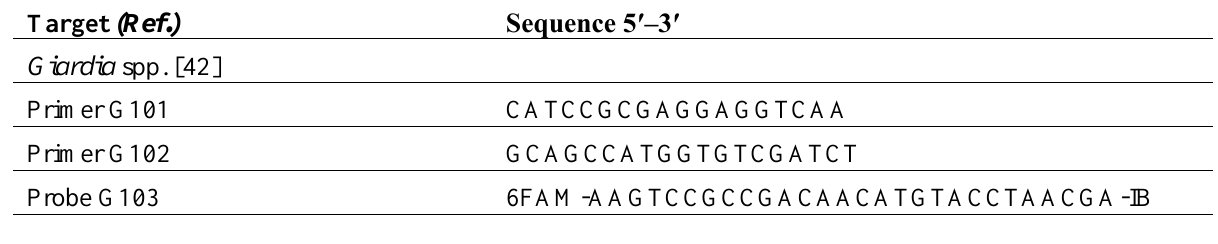
Table 2. Primers and Probes used in this